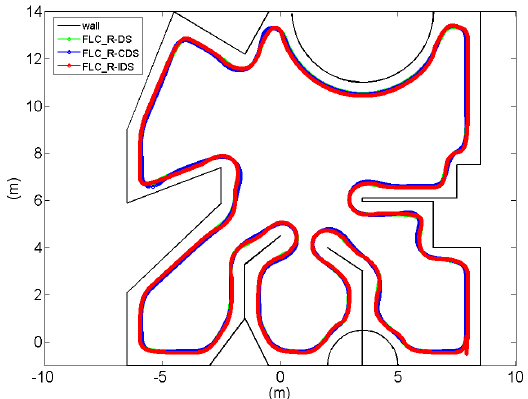
Figure 14. Comparison of the path tracking best performances of the proposed FLC_R-IDS, FLC_R-DS, and FLC_R-CDS methods in test environment 3. Table 6. Comparison of 30 controllers and their MAE values of various existing models in test environment 3.